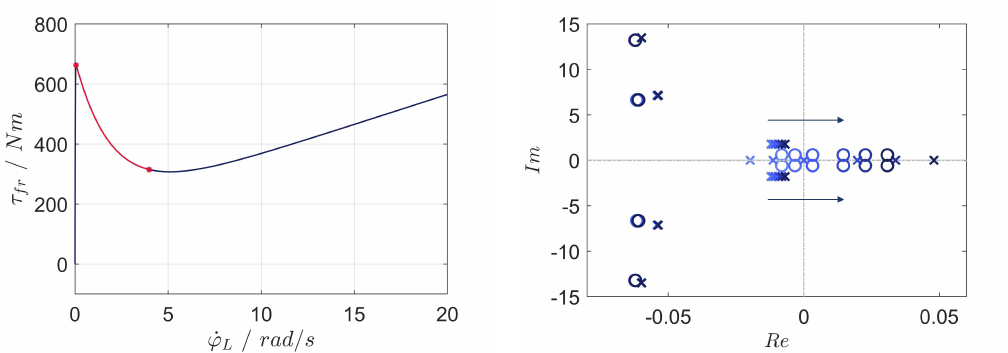
Figure 2. Friction curve ( left ): region of unstable operating points (red). Low-frequency part of pole-zero map of linearized systems ( right